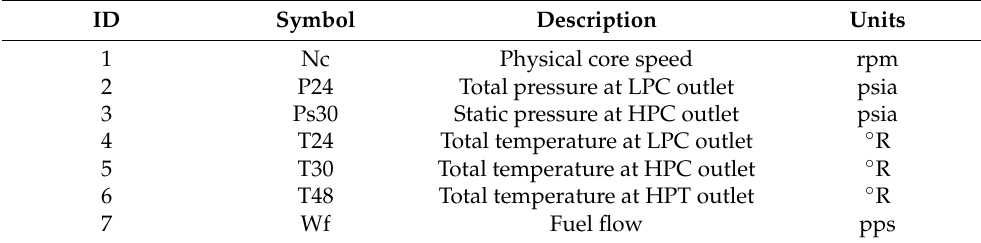
Table 3. Gas-path monitored variables Y in ProDiMES